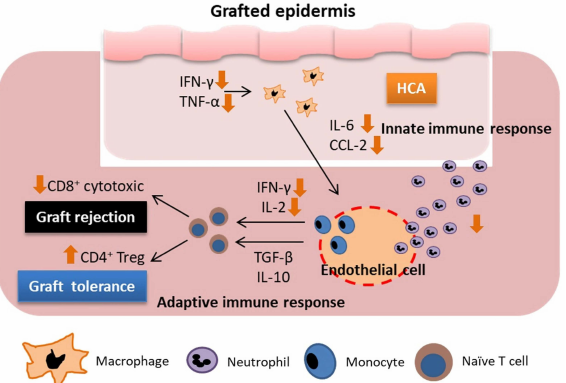
Figure 10. The diagram of the effects of HCA on the regulation of innate and adaptive immune cells in allograft